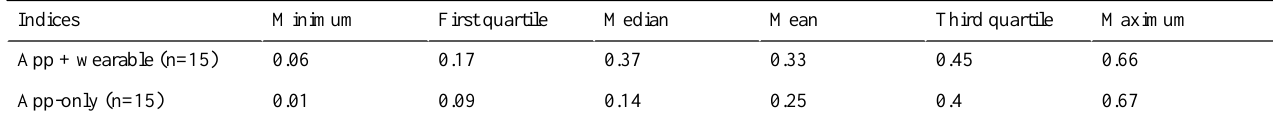
Table 4. Star-shaped pentagon plot area calculation with meal, snack, stress, and sleep log records. The area value was normalized between 0 to 1. Each intervention group participant’s minimum, first quartile, median, mean, third quartile, and maximum value was described below.